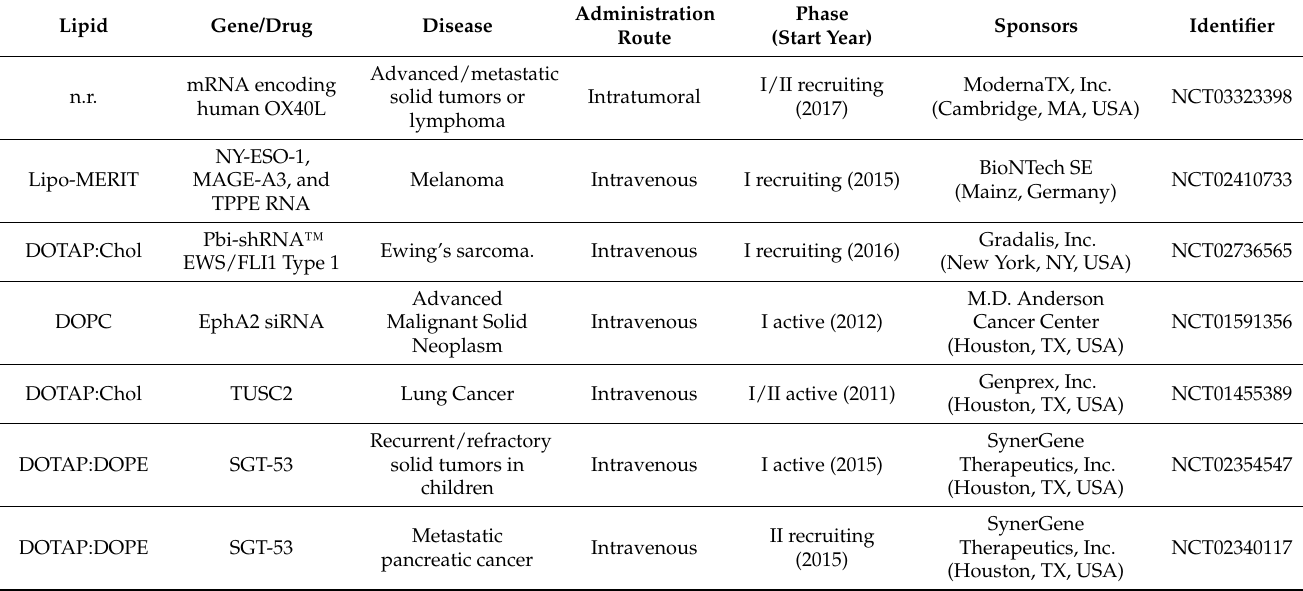
Table 3. Active clinical trials of lipoplex-based delivery systems containing nucleic acids for cancer treatment.